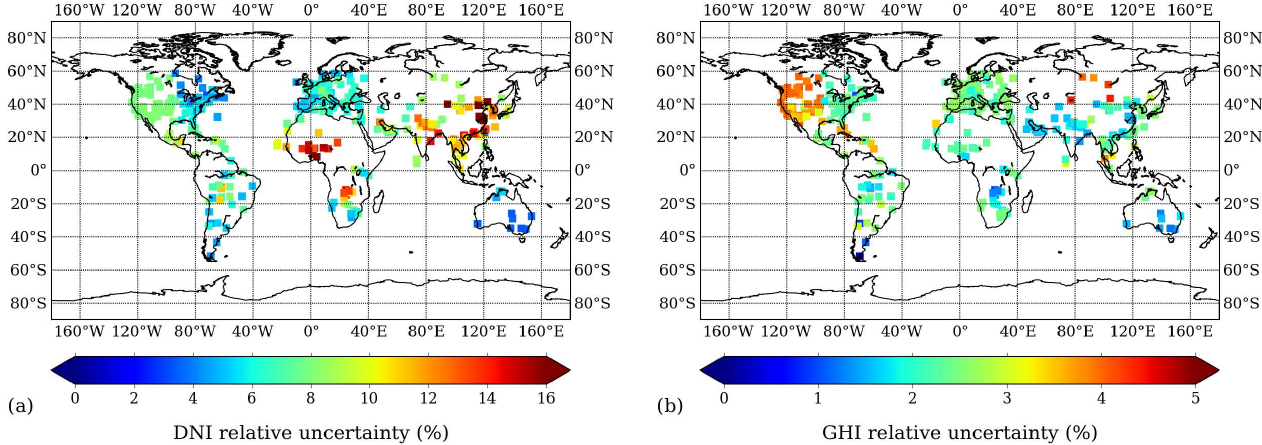
Fig. 10. Relative uncertainty in DNI and GHI at AERONET sites. The relative uncertainties are calculated from the mean measured AOD values at each site (Fig.